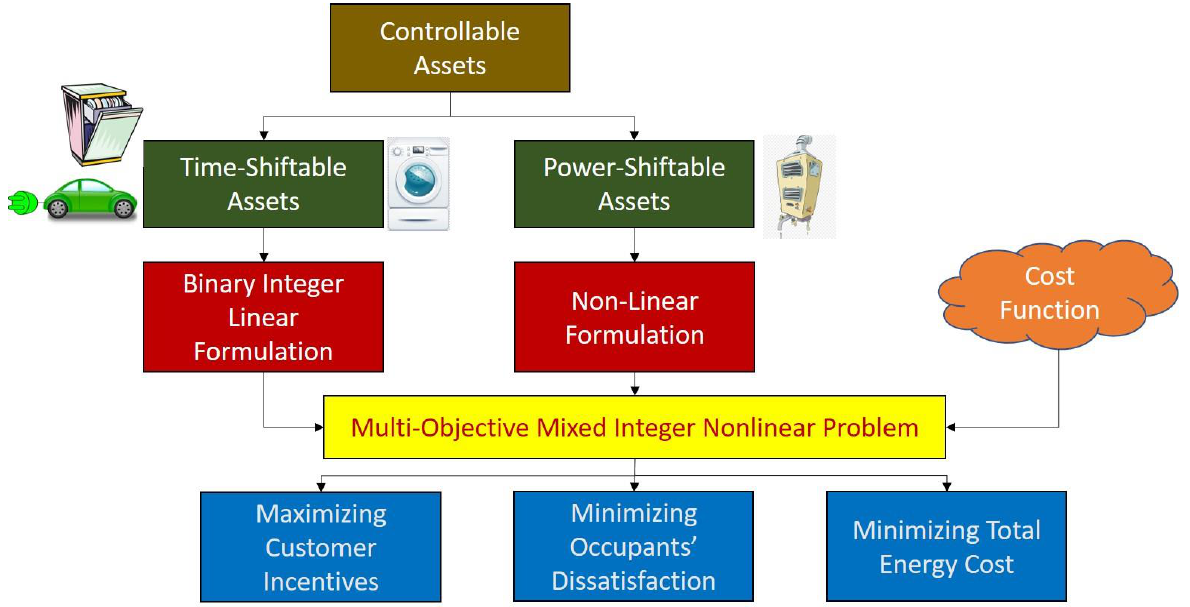
Figure 2. The flowchart of the proposed methodology.